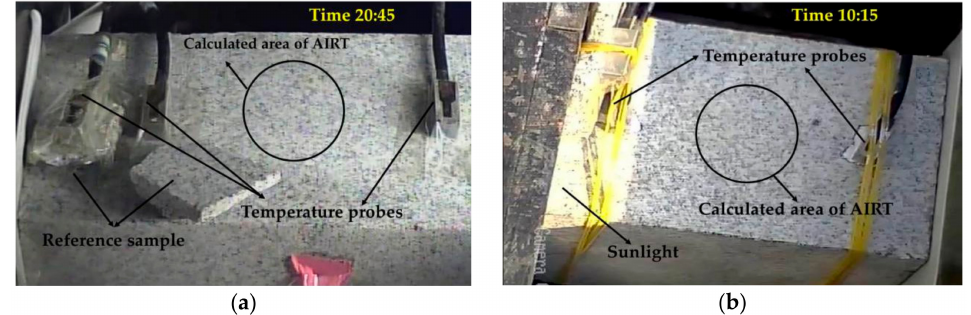
Figure 3. The photos of the samples and the arrangement of the temperature probes in these two types of environments: ( a ) HG-1 in the ‘EM1’; ( b ) HG-4 in the